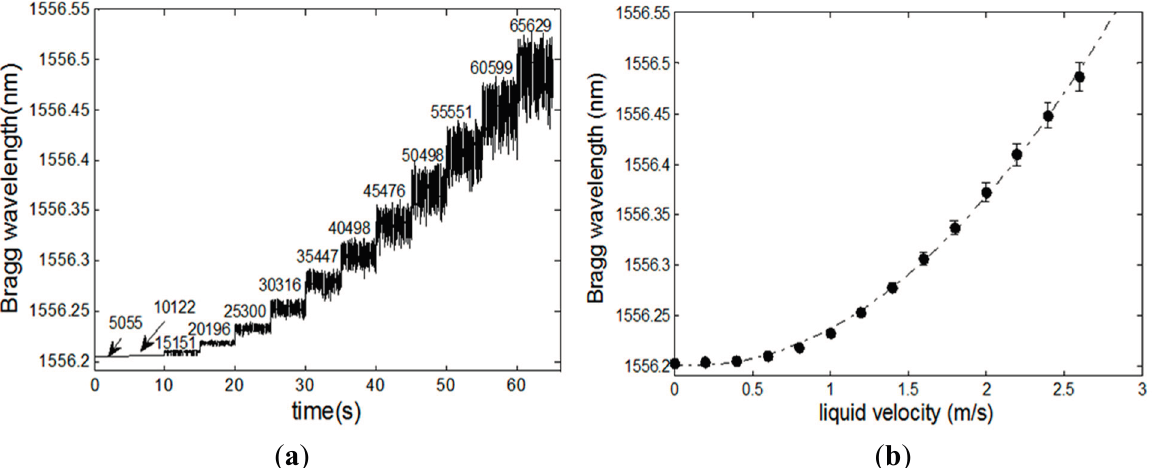
Figure 3. ( a ) Behavior of an FBG strain for single-flow and increasing velocities; the Reynold’s number increases, leading to increasing high frequency oscillations induced on the optical fiber sensor; ( b )Typical optical fiber Bragg grating wavelength shift and standard deviation against single-phase flow liquid